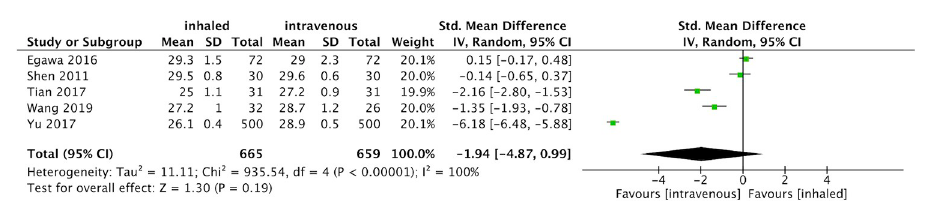
Fig 5. Forest plot for the postoperative MMSE scores between inhaled and propofol groups.